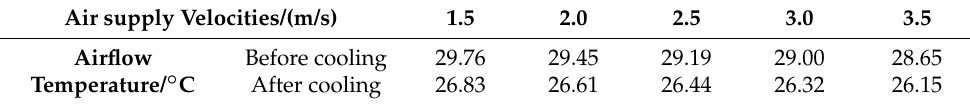
Figure 10. Variation of airflow temperature at measuring point 3 under different air supply velocities. Table 4. Temperature of measuring point 3 under different air supply velocities.